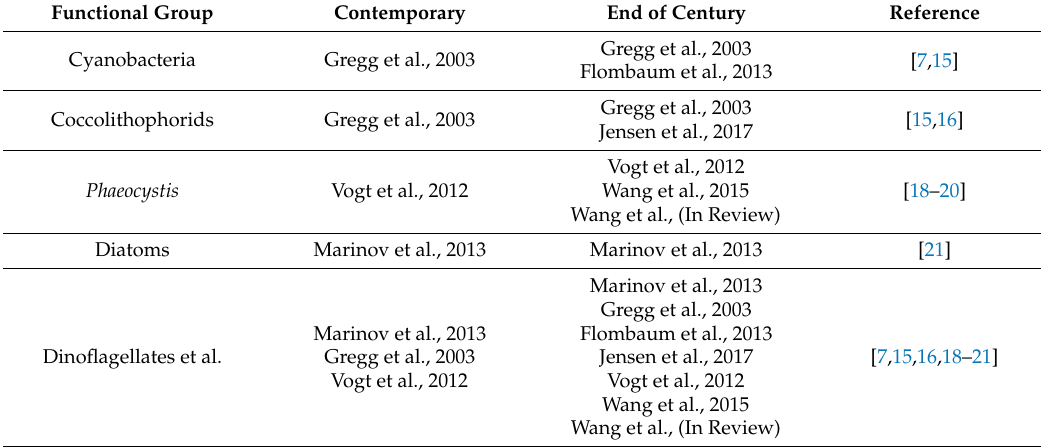
Table A3. The primary sources of information used for each of the functional groups for present day and end of century.